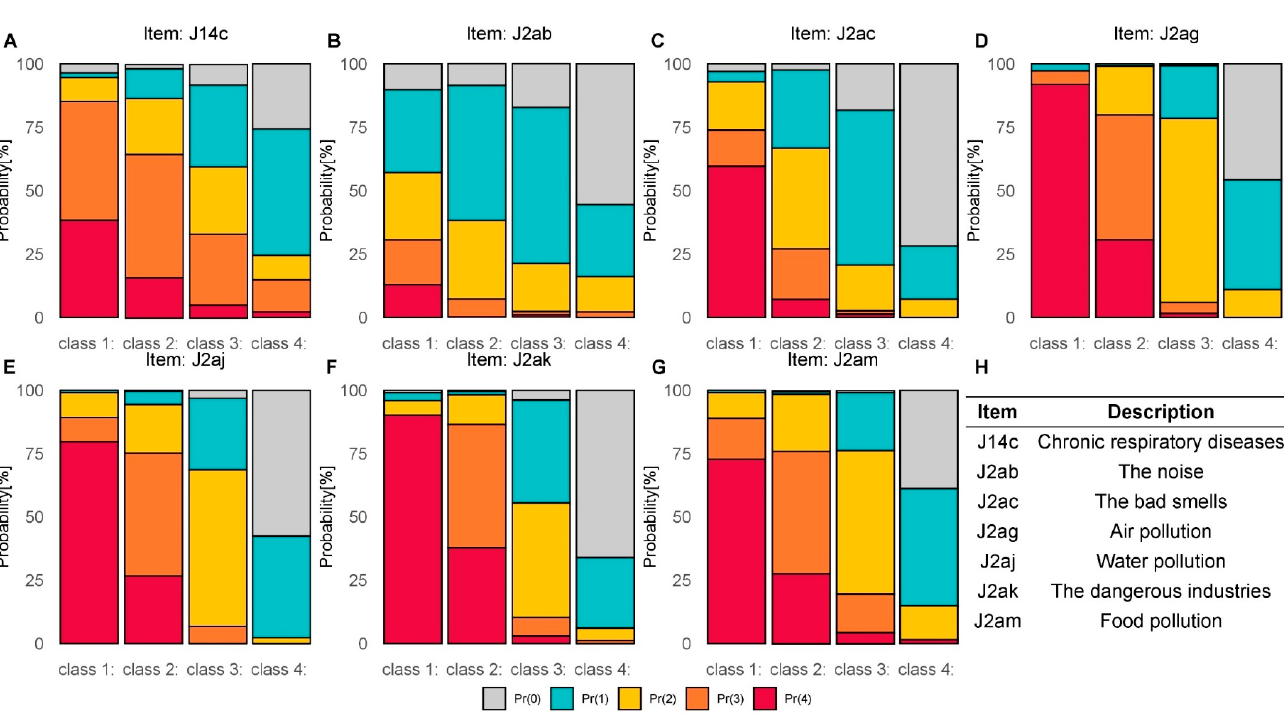
Figure 2. Percentages of responses (from 0 to 4) to the selected items in each class from the latent class analysis (LCA). Table 5. Percentages or average mean and standard deviation of the national priority contaminated sites, area, educational level, and age, according to the classes from the latent class analysis (LCA).